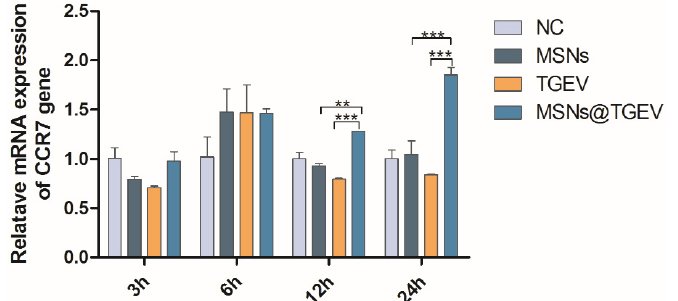
Figure 6. mRNA expression of CCR7 on DCs after incubation with the inactivated TGEV vaccine with MSNs for different times. Im-DCs were cultured with MSNs, inactivated TGEV and inactivated TGEV vaccine with MSNs, and cells were harvested at 3 h, 6 h, 12 h, and 24 h, respectively. Im-DCs untreated were negative control. mRNA expression of CCR7 was assessed by real-time PCR. Data were presented as mean ± SD of three duplicate samples. Differences were considered significant at (**) p < 0.01, (***) p < 0.001.